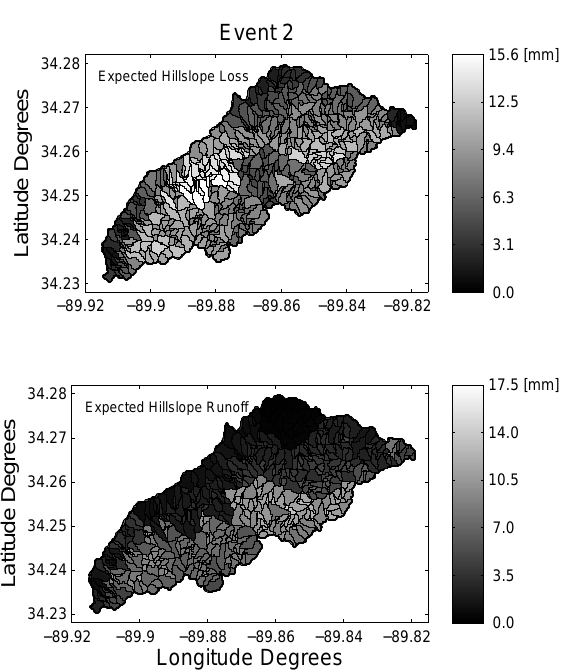
Fig. 10. The expected water loss and runoff of each hillslope for event i = 2; i.e. E [ L 2 ,j,k ] and r 2 ,j,k − E [ L 2 ,j,k ] .